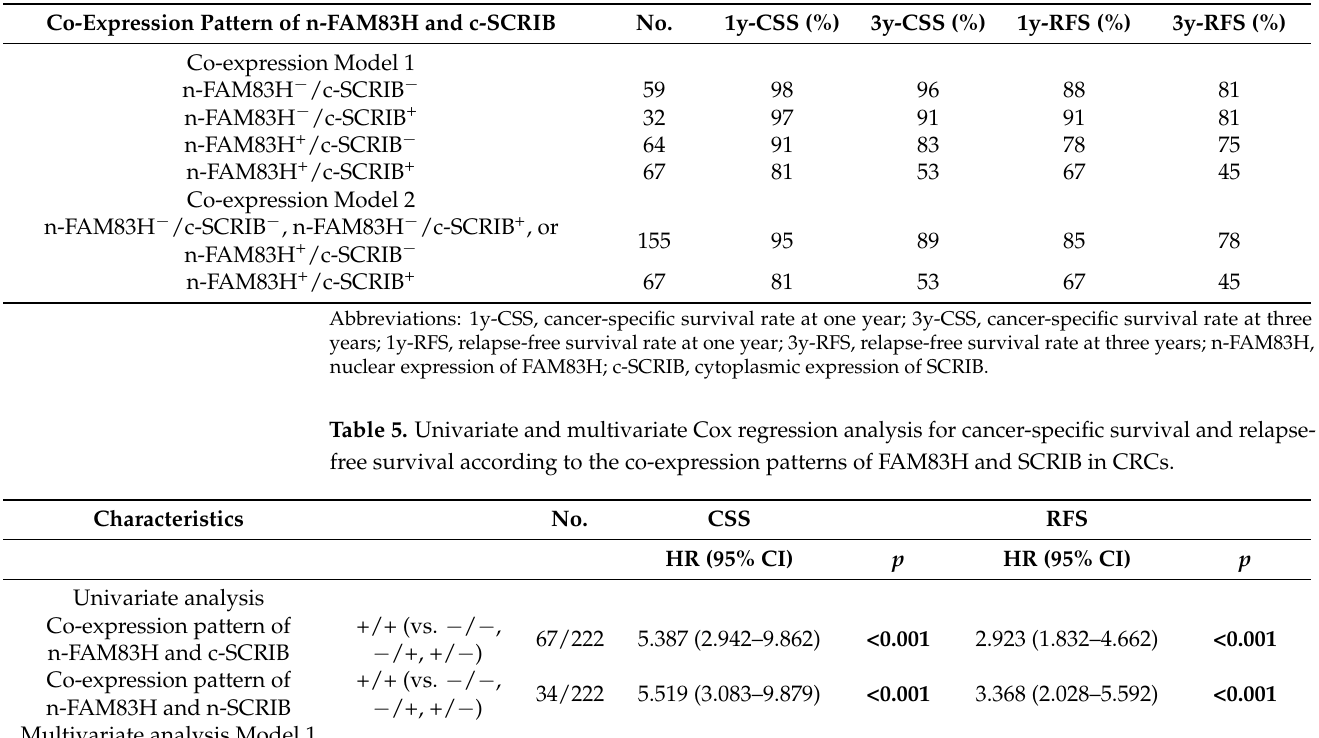
Table 4. One- and three-year cancer-specific survival and relapse-free survival according to co- expression patterns of n-FAM83H and c-SCRIB.